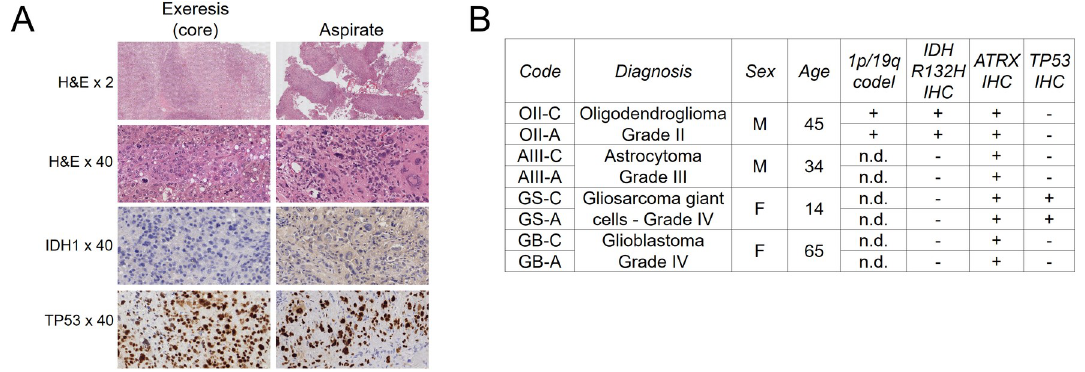
Fig 1. The diagnosis of glioma aspirates is highly similar to their corresponding core resections. A , Representative immunohistochemistry images of the gliosarcoma of giant cells used in this study. H&E, haemotoxylin and eosin. B , Diagnosis of the samples used in the present study. C = tumour core resection. A = cavitational ultrasonic surgical aspirate. Age = Age at